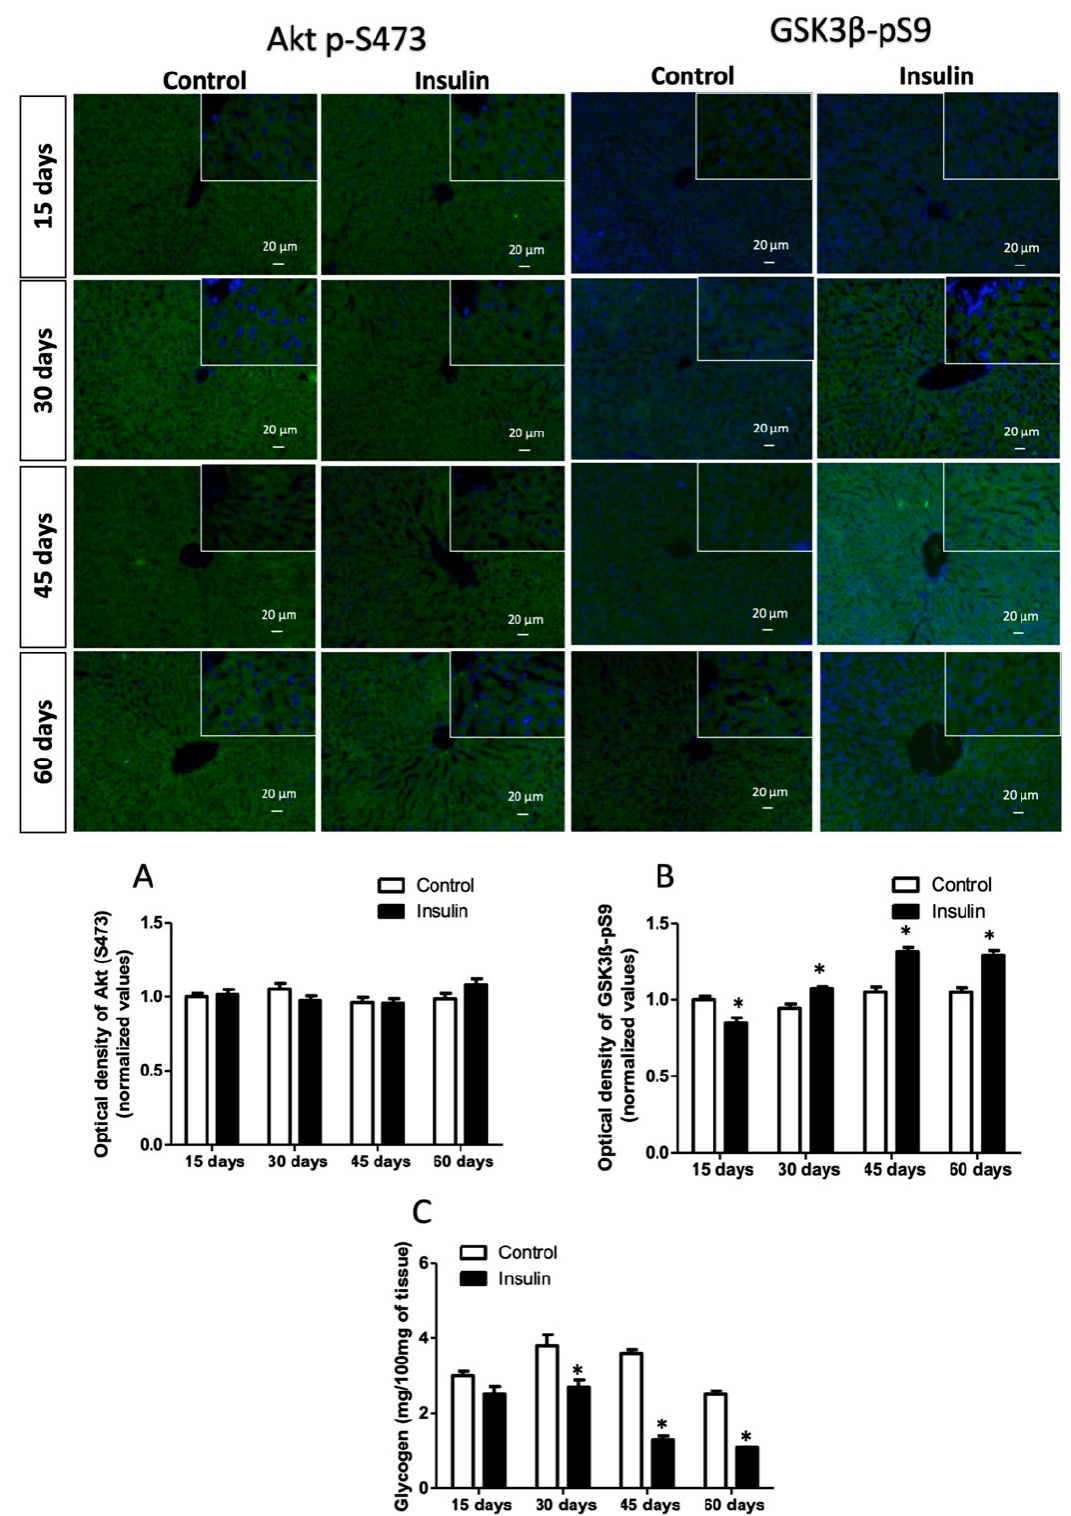
Figure 3. Evaluation of the hepatic glycogen pathway. ( A ) Serine phosphorylation of Akt (S473); ( B ) serine phosphorylation of GSK3 β (S9); ( C ) hepatic glycogen concentration. Results are the mean average of 10 separate experimental animals per group ± SEM. (*) indicates a significant difference compared to the control groups ( p ≤ 0.05). The optical density of figures ( A , B ) was analyzed with the Mann–Whitney U test, while the Student’s t -test analyzed glycogen ( C ). The scale bar corresponds to 20 µ m in a magnification of 400 ×.